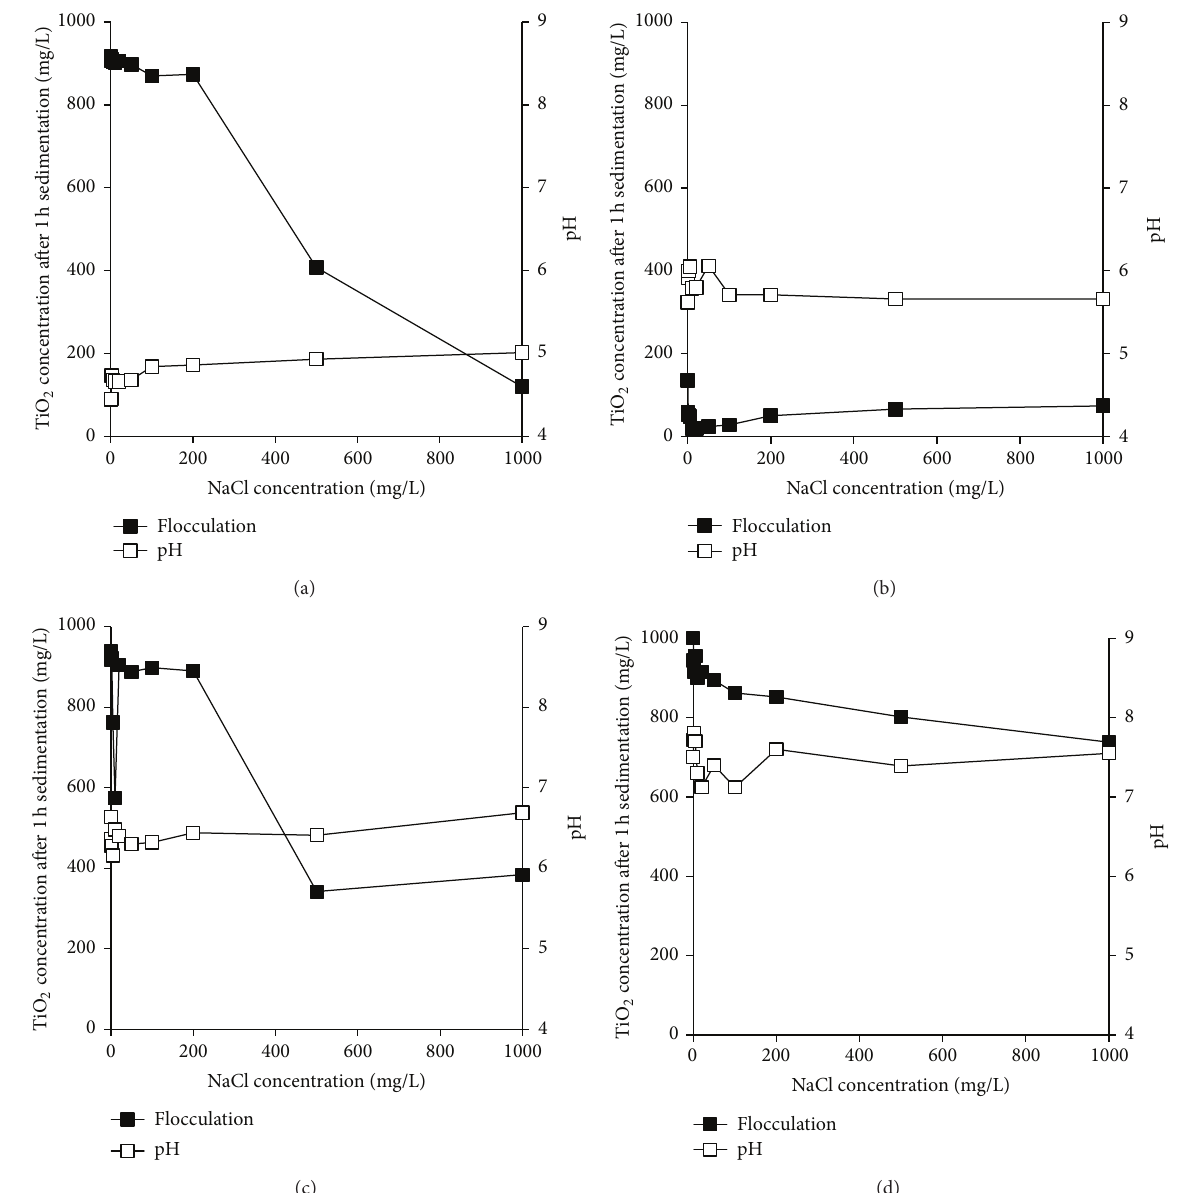
Figure 2: Photocatalyst flocculation and pH in 1g/L TiO 2 “P25” suspensions in aqueous solutions with no (a), 10 (b), 20 (c), and 50 mg/L (d) humic acid sodium salt, HANa, at different NaCl